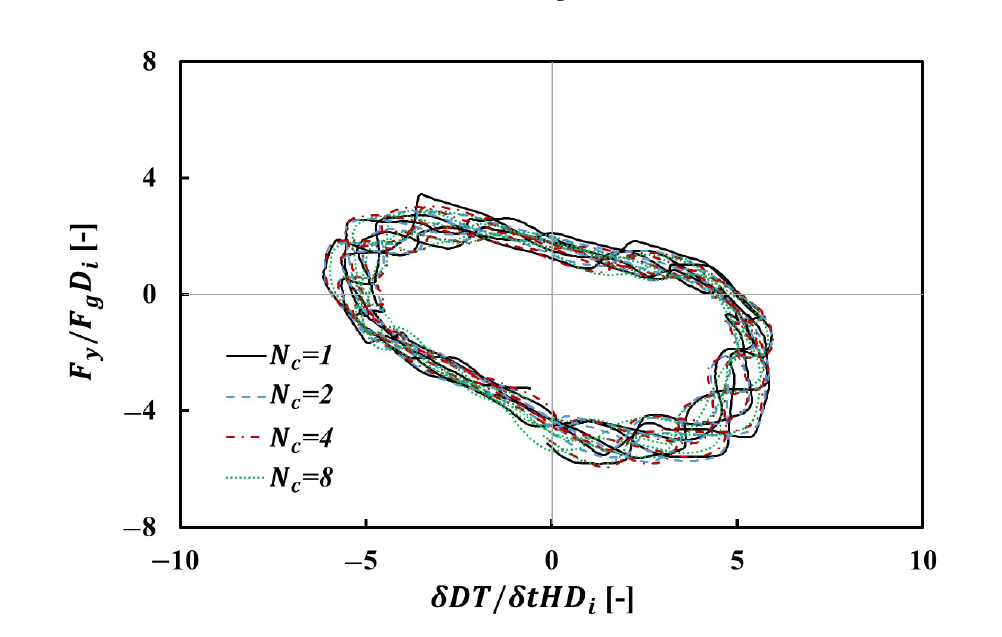
Figure 25. Normalised force–velocity diagram for the last five oscillation cycles with D i =